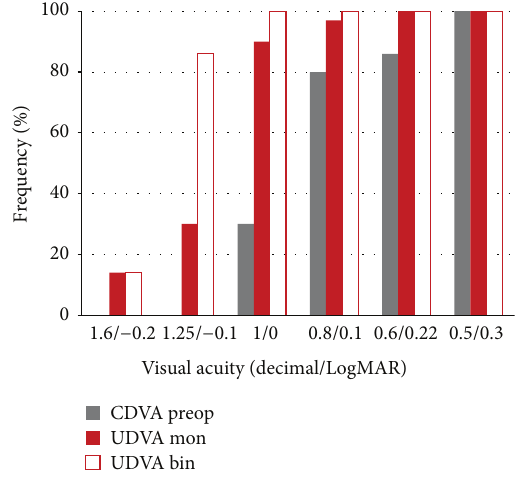
Figure 2: Postoperative distance visual outcomes at 3 months after surgery in the analysed sample. UDVA: uncorrected distance visual acuity; CDVA: corrected distance visual acuity; mon: monocular; bin: binocular; preop: